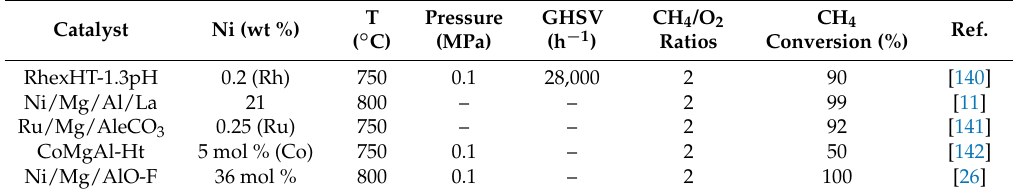
Table 5. Catalytic performance of partial oxidation of CH 4 for different catalysts in different